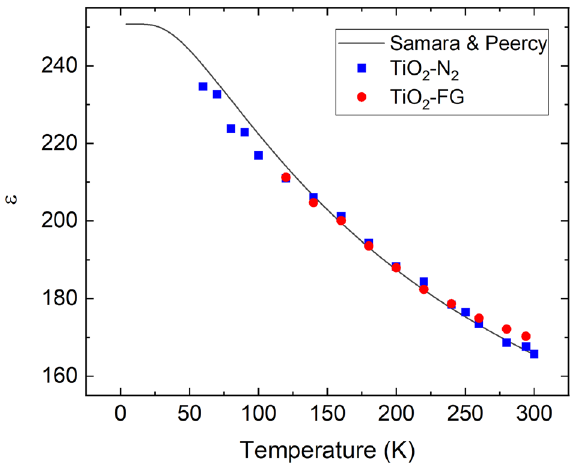
Figure 2. Temperature dependence of the c-axis permittivity ( ε ) of conductive, n-type TiO 2 obtained after heat treatments in FG and N 2 ; and a modified Curie–Weiss dependence with the parameters determined by Samara and Peercy 6 (solid